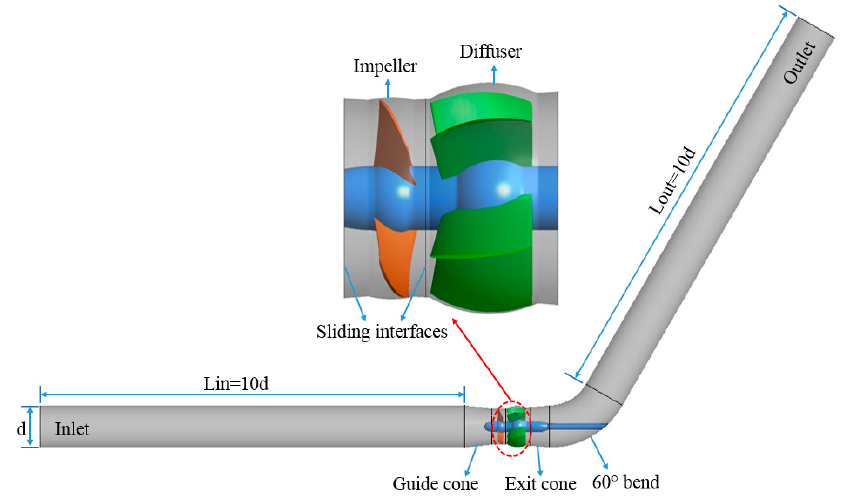
Figure 3. Three-dimensional view of the computational zone.